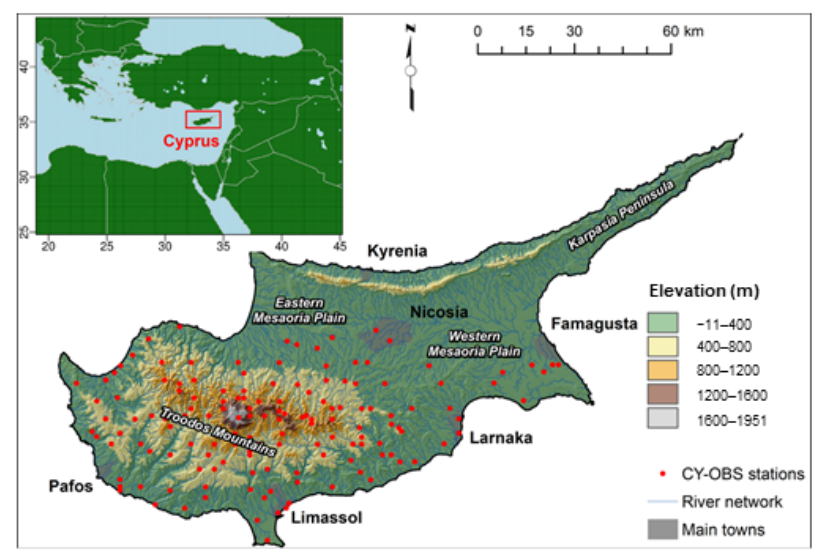
Figure 1. Extend of the simulation domain (top left), main topographic characteristics of the island of Cyprus and location of weather stations.